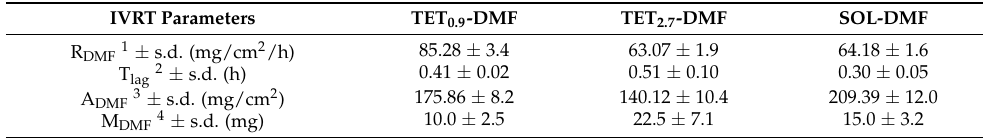
Table 3. IVRT parameters of the indicated formulations, as determined by Franz cells associated with PTFE.